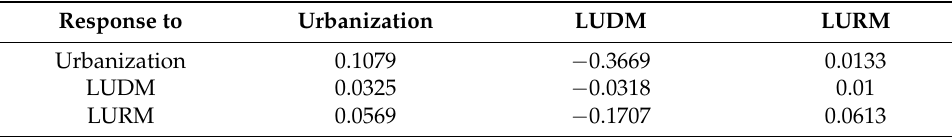
Figure 3. Pulse response results of Model 1. Table 8. Cumulative impulse response values of Model